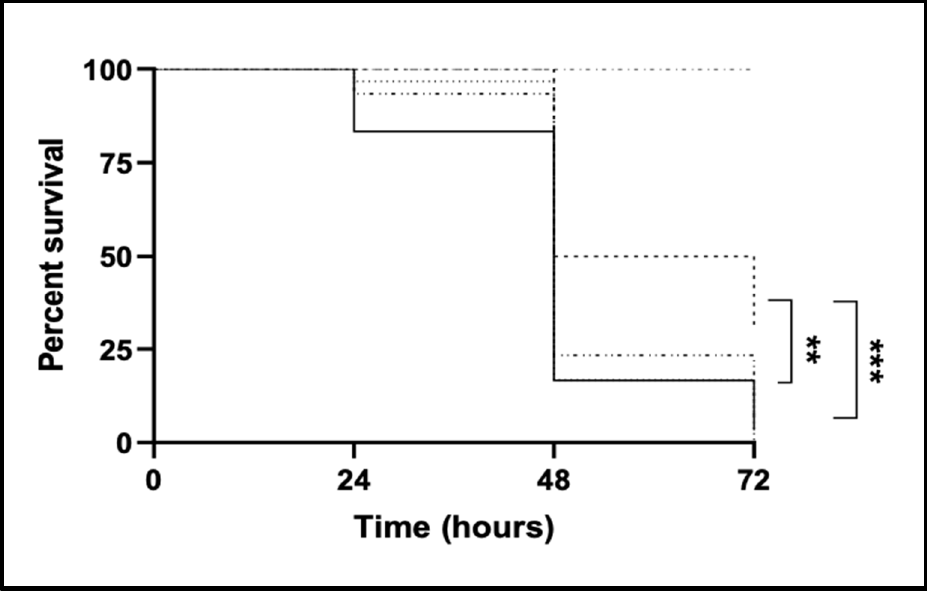
Figure 1. CgTPO4 expression is required for C. glabrata virulence against the G. mellonella infection model. The survival of larvae injected with approximately 5 × 10 6 CFU/larvae of wild-type KUE100 C. glabrata , harboring the pGREG576 cloning vector ( ), or the pGREG576_MTI_ CgTPO4 expression plasmid ( ), and of C. glabrata deletion mutant Δcgtpo4 , harboring the pGREG576 cloning vector ( ) or the pGREG576_MTI_ CgTPO4 expression plasmid ( ), with PBS for control ( ) are displayed as Kaplan–Meier survival curves. The displayed results are the average of at least three independent experiments, with standard deviation represented by the grey lines. ** p < 0.01, *** p < 0.001.